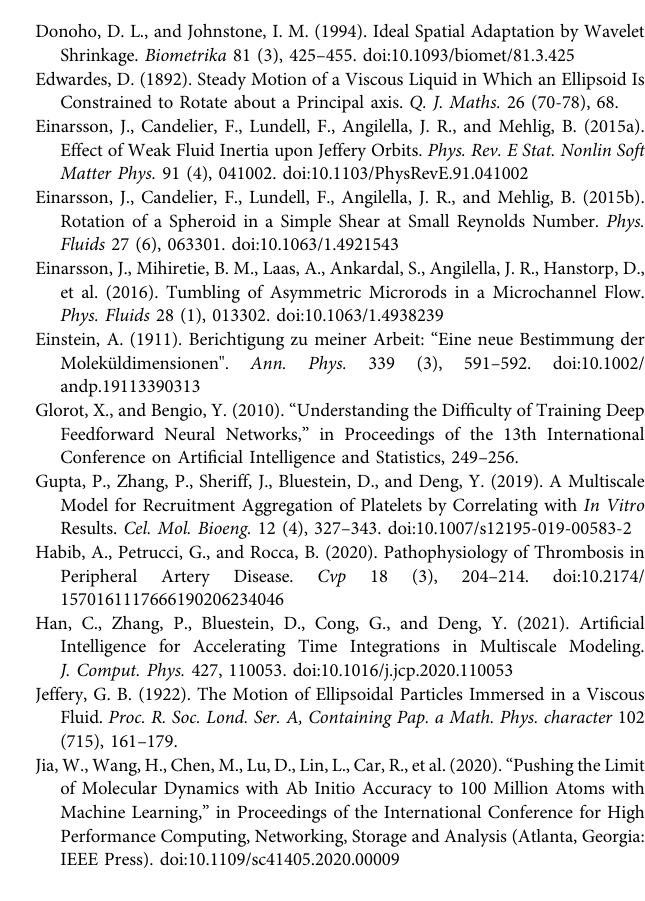
SupplementaryVideoS1| AnimationsoftheBIOLframeworkfordeformablebody platelet simulations. Supplementary Video S2 | Animations of the BIOL framework for rigid body platelet